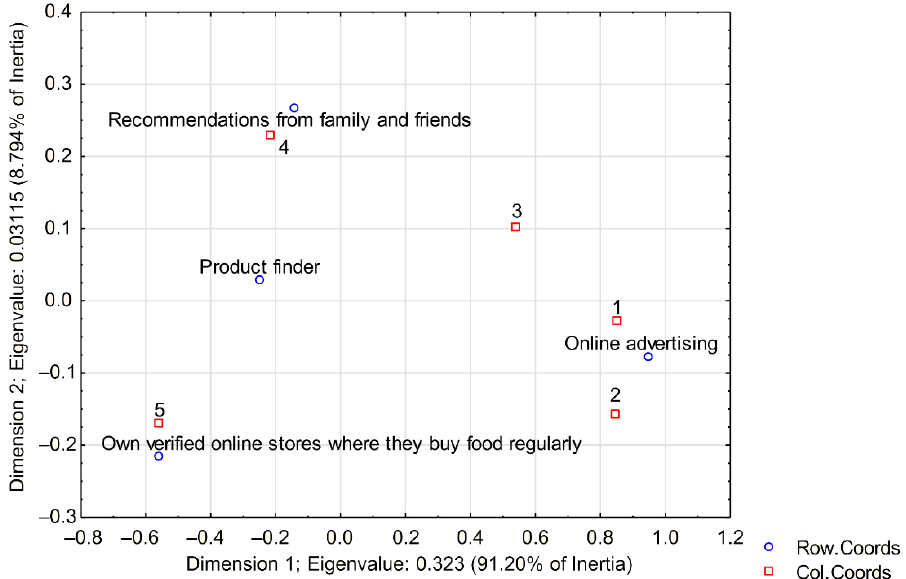
Figure 2. Correspondence map; variables How do you look for online grocery store? a Level of agreement.